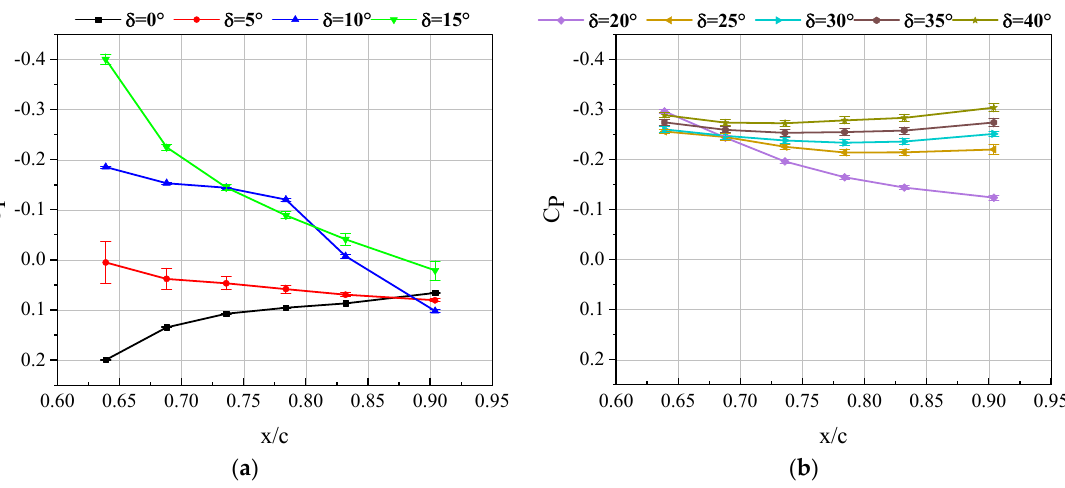
Figure 9. Rudder pressure distribution at different deflection angles: ( a ) δ = 0°~15°; ( b ) δ = 20°~40° ( β = − 10°, Re = 2.12 × 10 5 ).